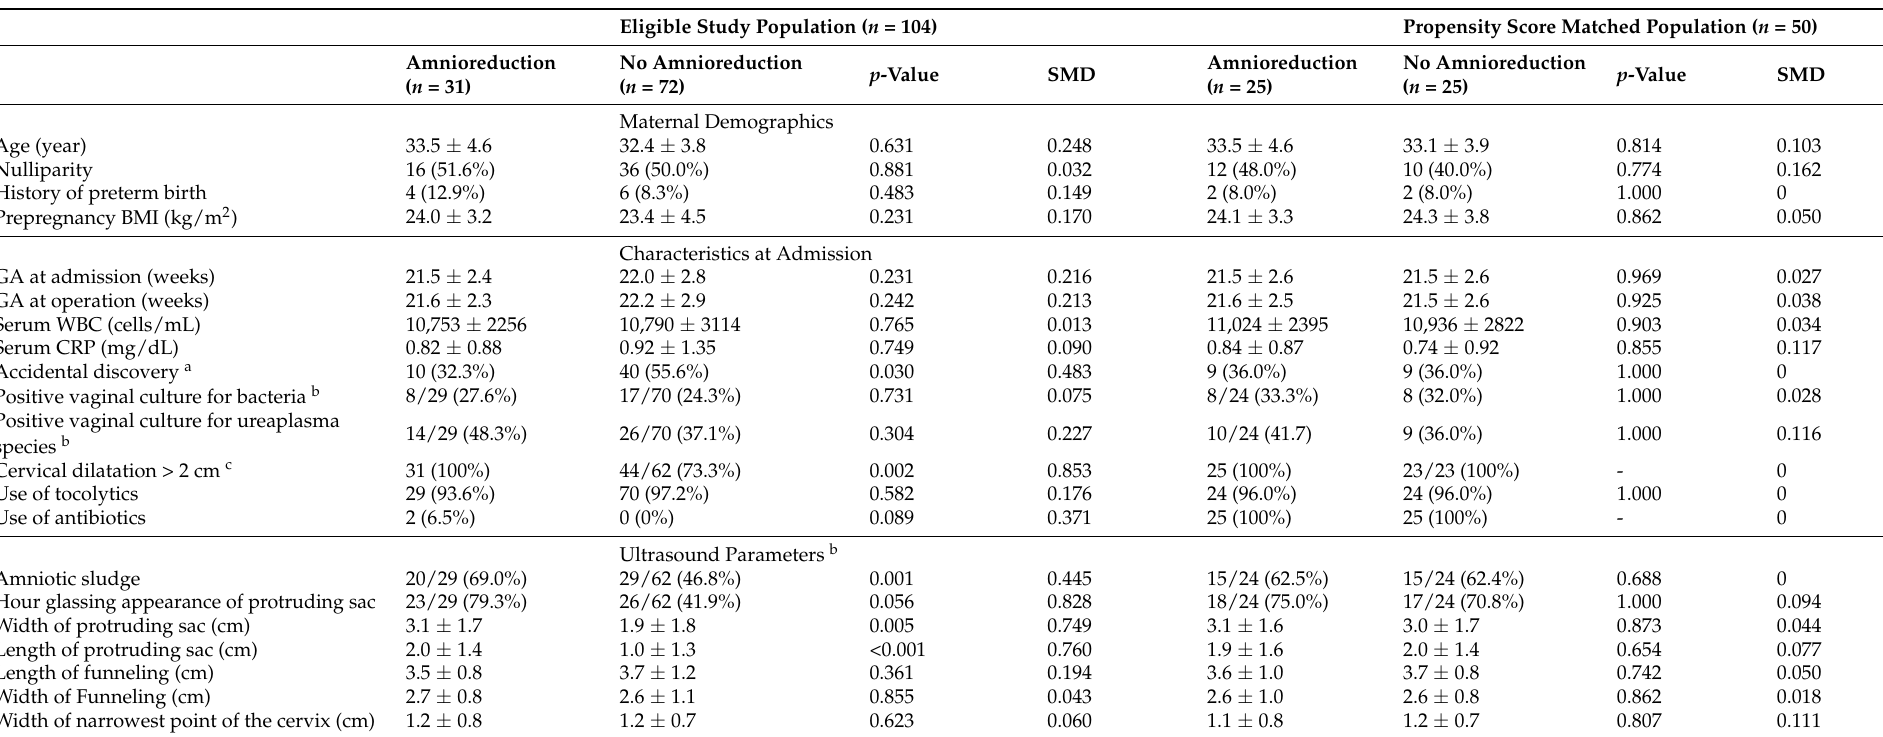
Table 1. Baseline characteristics and ultrasound parameters of the eligible study population and propensity score-matched